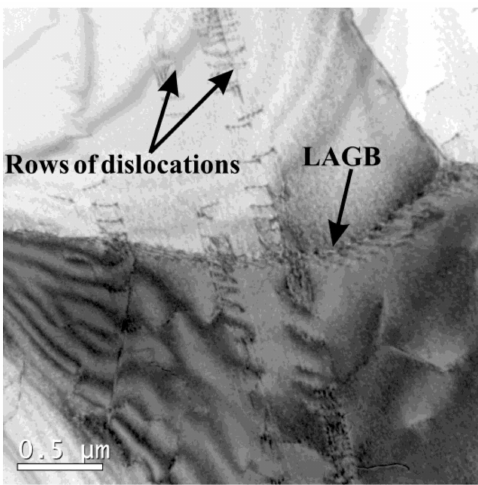
Figure 14. Dislocation morphology in 18Mn18Cr0.6N compressed at a cooling rate of 0.025 Ks − 1 to a strain of 0.4.